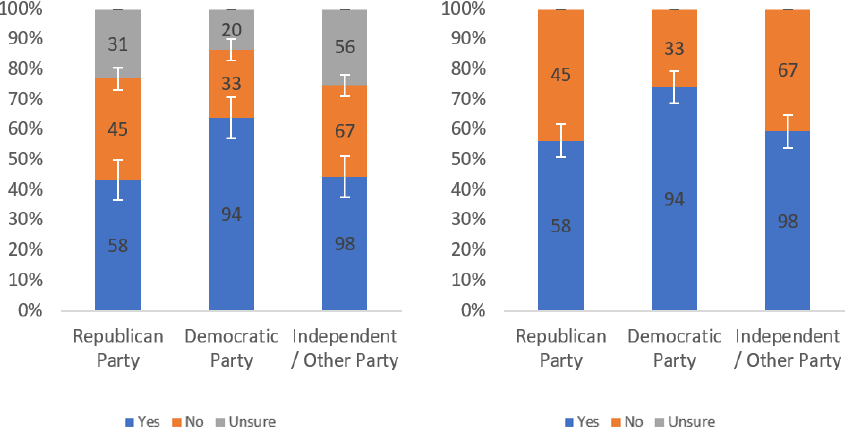
Figure A14. Responses regarding usefulness in judging trustworthiness by party affiliation including ( left ) and excluding ( right ) unsure responses.